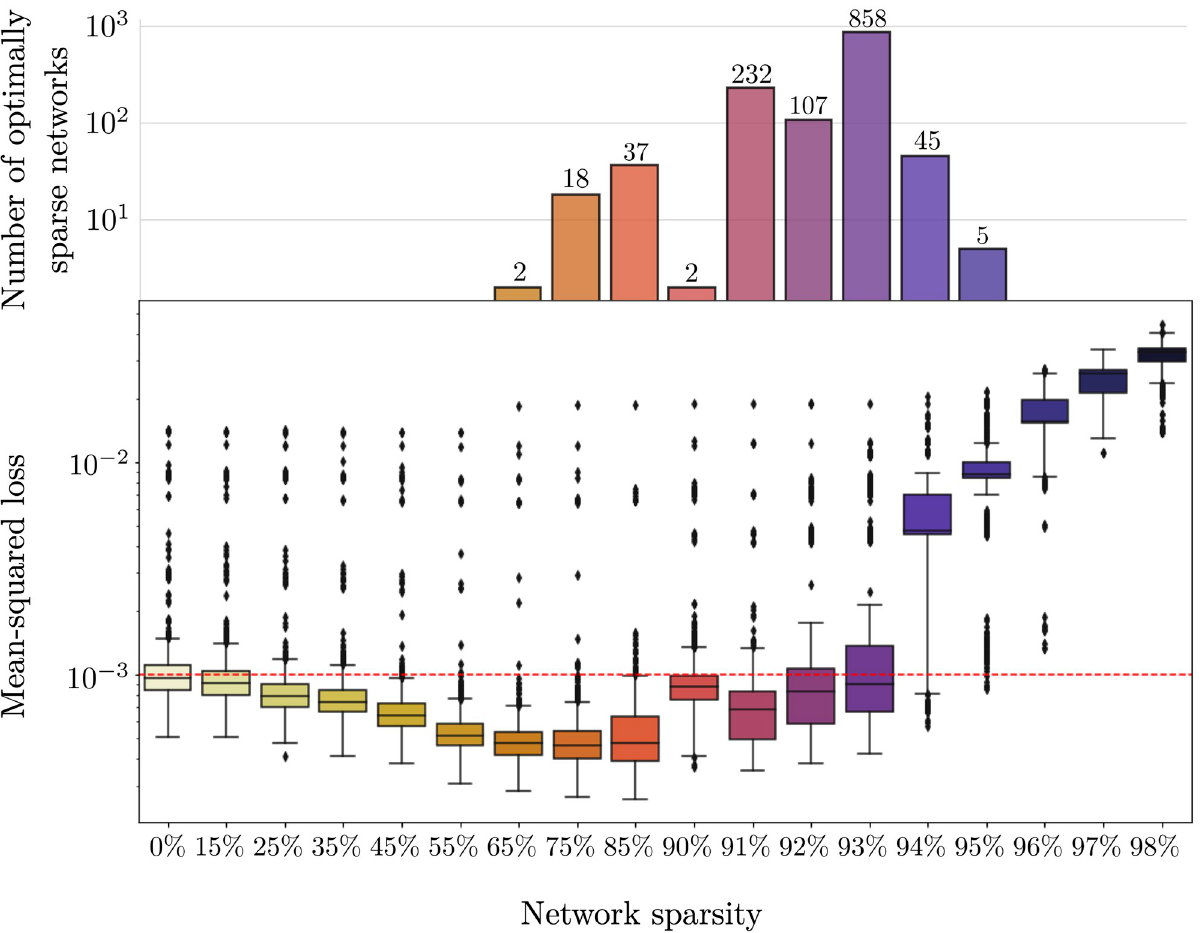
Fig 4. Monte Carlo analysis of pruned networks. 1320 networks are sequentially pruned and loss of the pruned networks at each sparsity percentage is recorded in the box plot. The bar plot records the number of networks that make it to the corresponding sparsity percentage before exceeding the hypothetical threshold (10 − 3 ).